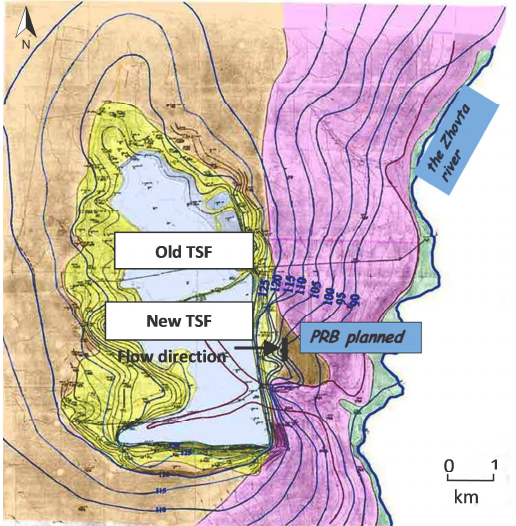
Figure 2 . Hydrogeological map of the tailings storage facility site with hydroisohypses of the